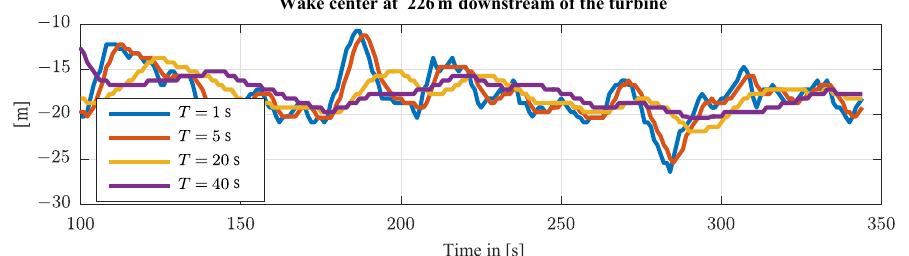
Figure 2. Time evolution of wake center (at a 1.8 D downwind distance) when different window lengths T are used to average the flow during the wake center